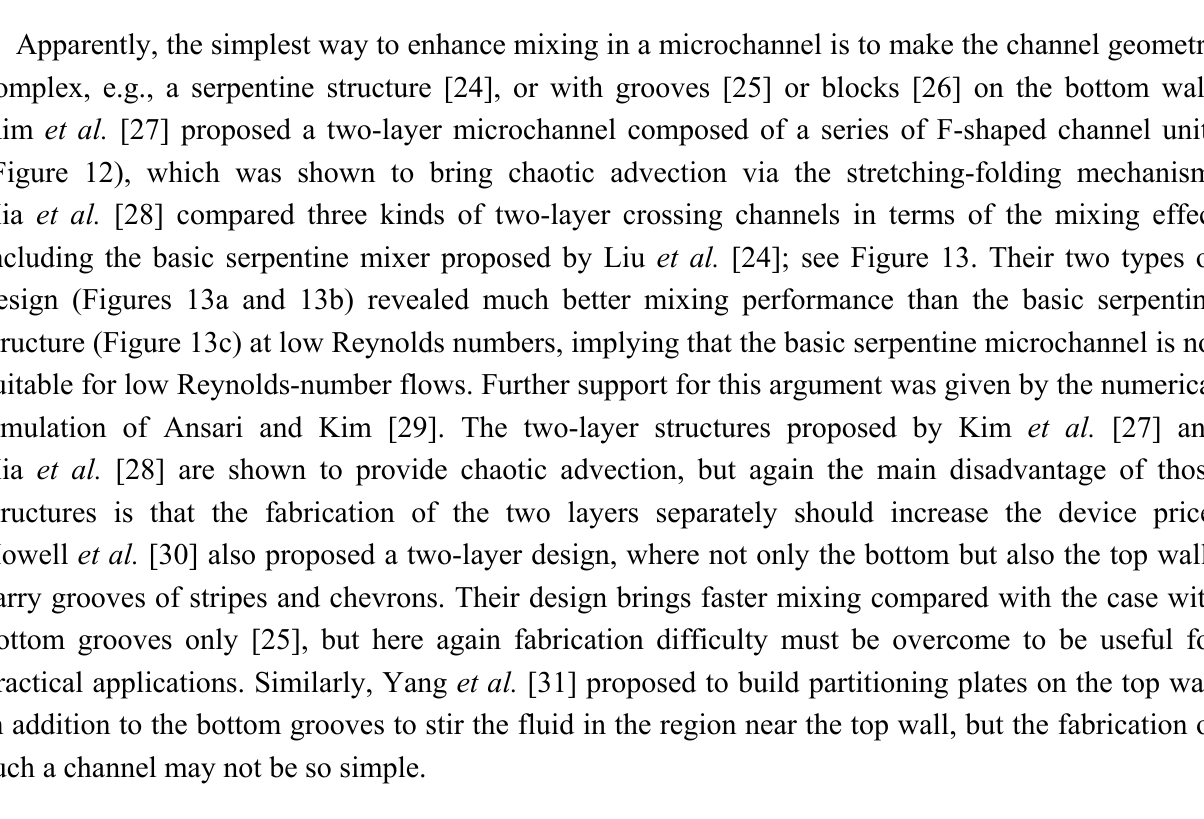
Figure 12. A serpentine laminating micromixer composed of a series of F-shaped channel units (from Kim et al.